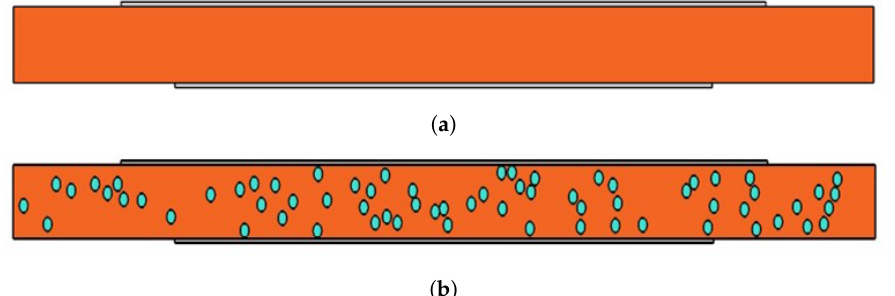
Figure 6. Modified 2D simulation model to adapt the realized varactor. ( a , b ) are the model without and with 10% LDK inclusions (blue) respectively. The electrodes are 0.01 mm thick and the BST (orange) region is 16 × 0.85 mm 2 in dimensions close to the measured dimensions of the realized varactors. Each inclusion is 0.16 mm in diameter.